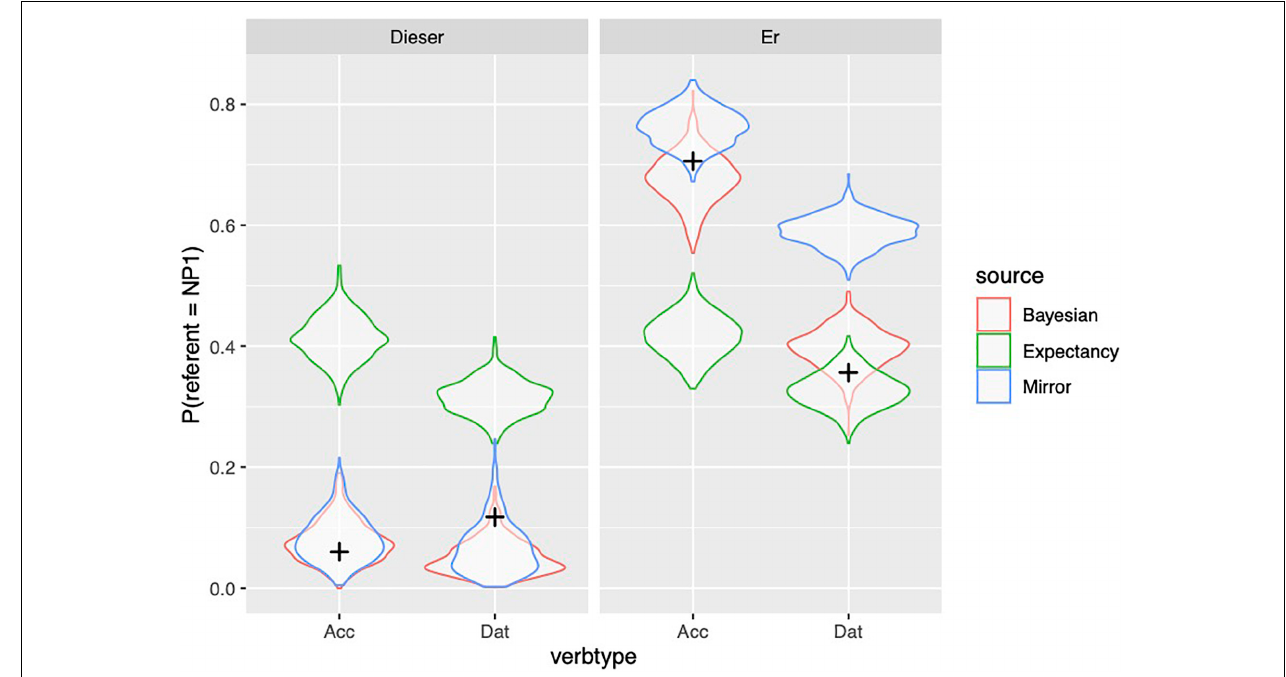
FIGURE 4 | Observed proportion of responses (from held out data, Experiment 1) are depicted with black crosses; distribution of simulated proportions based on the model predictions are depicted with violin plots.